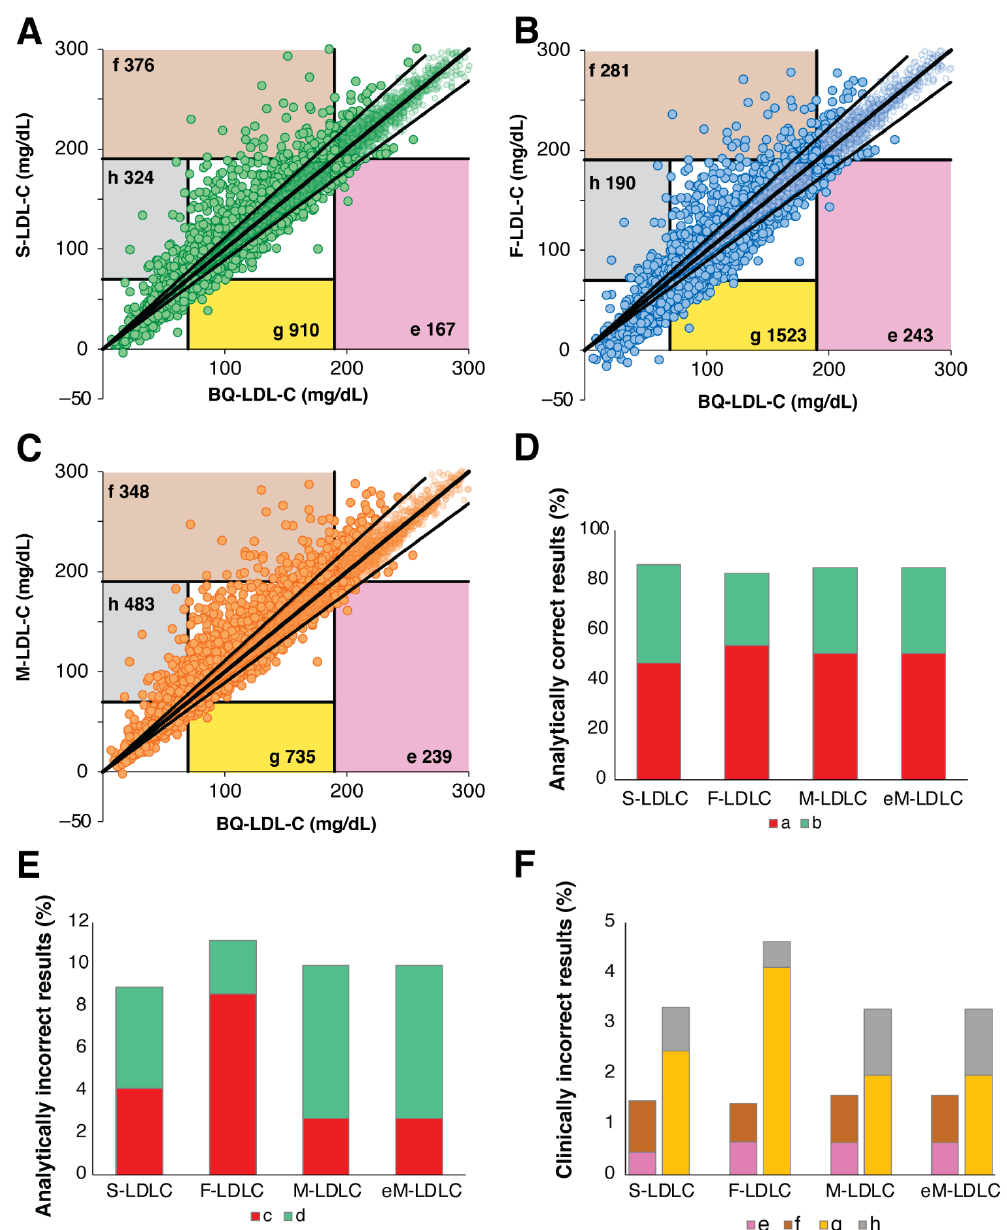
Figure 7. Error Grid Analysis for low TG samples. Definition of type of errors are the same as shown in Figure 6A. Error grid analysis was performed for patients (N = 37,088) with TG < 400 mg/dL and BQ-LDL-C ≤ 300 mg/dL for LDL-C calculated by the S-LDL-C (Panel A ), F-LDL-C (Panel B ), M-LDL- C (Panel C ) equations. Percent of analytically correct results within 12% proportional error (Panel D , Zones a + b) and incorrect analytical results (Panel E , Zones c + d) are shown. Clinically relevant errors affecting classification at low (Zones e + f) and high (Zones g + h) LDL-C cut-points are shown in (Panel F ).